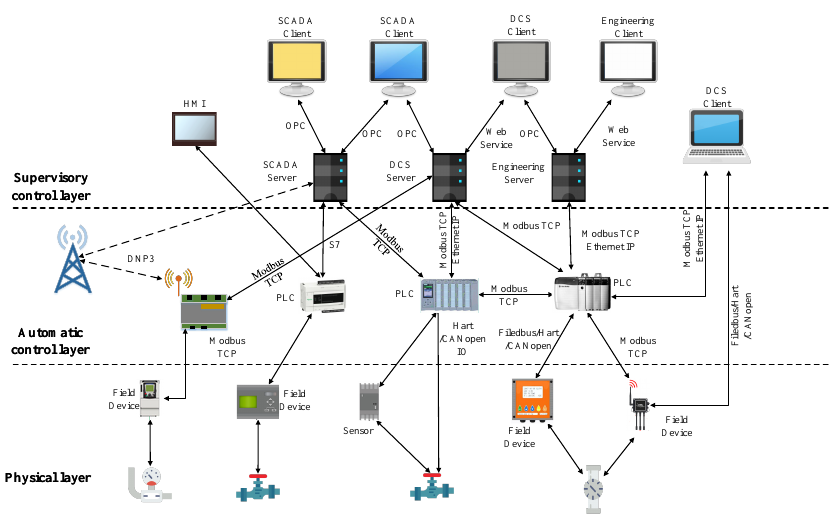
Figure 2. SCADA system